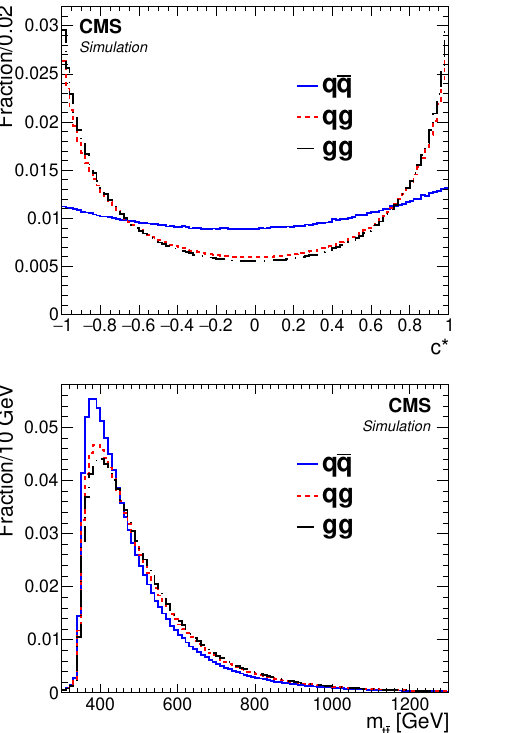
Figure 3 . The generator-level c (cid:3) (upper left), j x normalized to unity for the subprocesses qq, qg, and gg ! tt. The dilution factor, when taking the longitudinal direction of the tt pair in the lab frame as the quark direction for qq events, is shown in the lower right plot as a function of j x